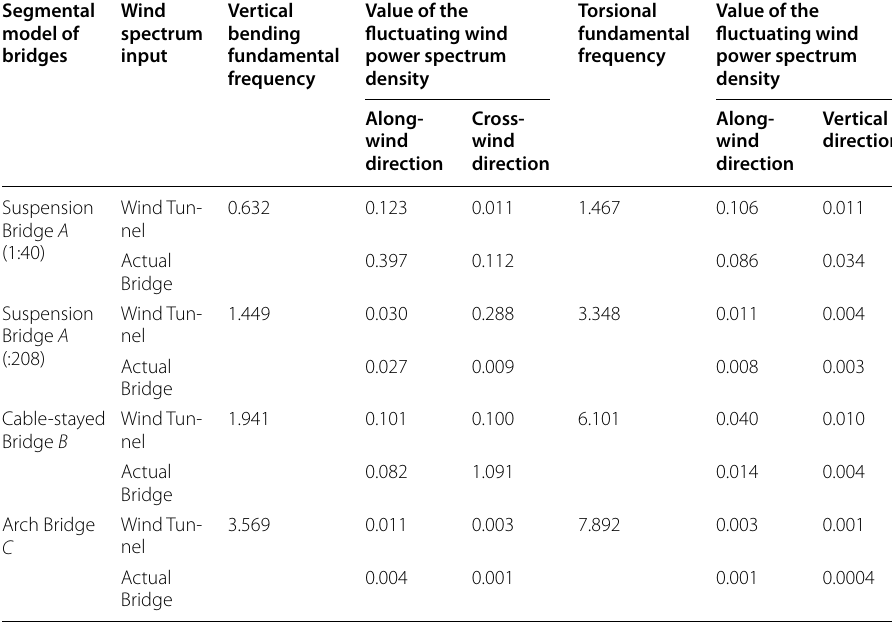
Table 6 Fluctuating wind power spectrum density under different turbulence integral scales Segmental model of